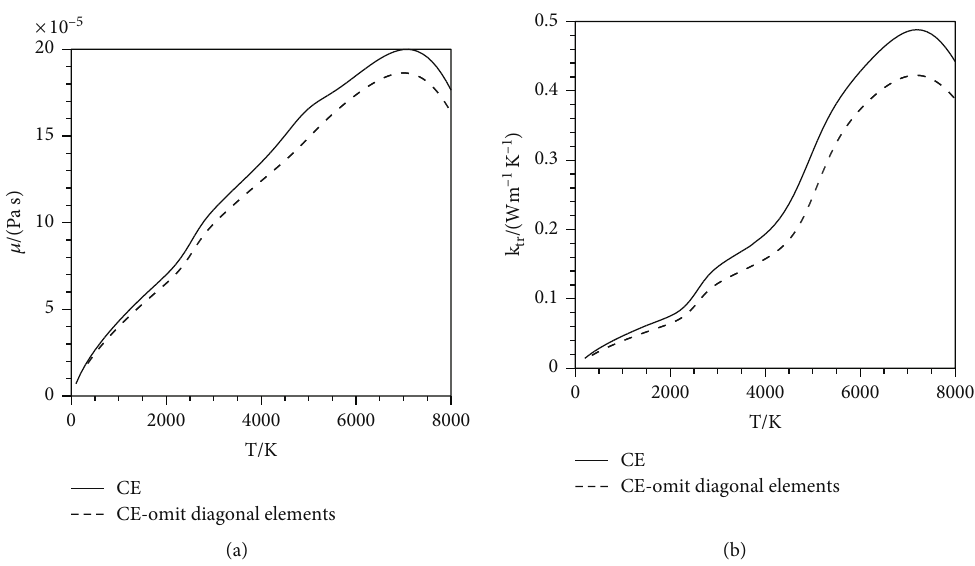
Figure 4: E ff ect of o ff -diagonal elements on viscosity and translational thermal conductivity. (a) Viscosity; (b) translational thermal conductivity.